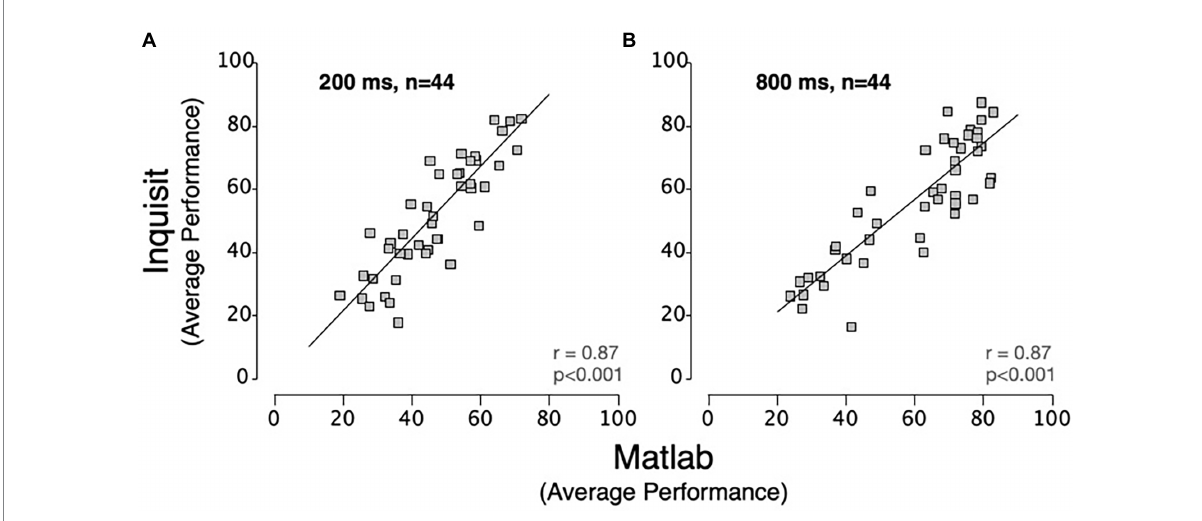
FIGURE 3 Scatter plots showing inter-platform relationships between MATLAB and Inquisit Millisecond for (A) 200 ms and (B) 800 ms RDM Durations. Each data point represents the mean performance of a single participant for each platform. The lines are trendlines fitted to the data (Pearson’s correlation: p < 0.001 for both 200 ms and 800 ms